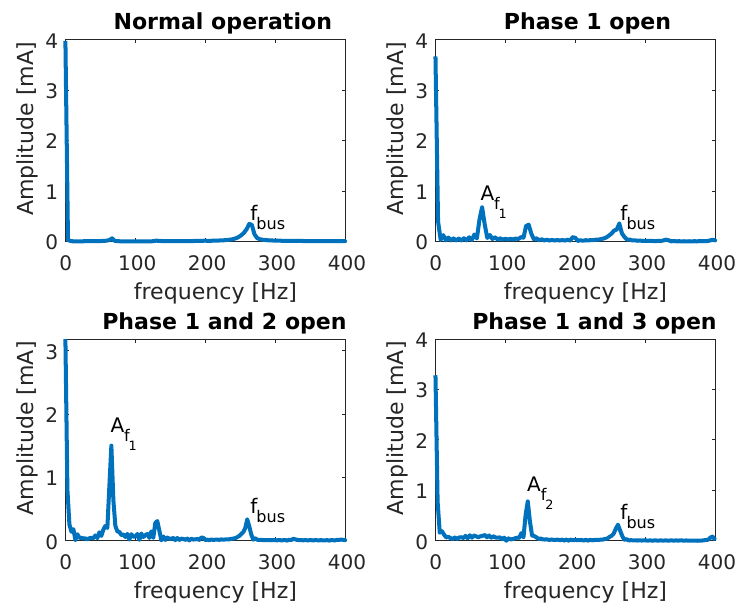
Figure 6. Excitation bus current spectrum.